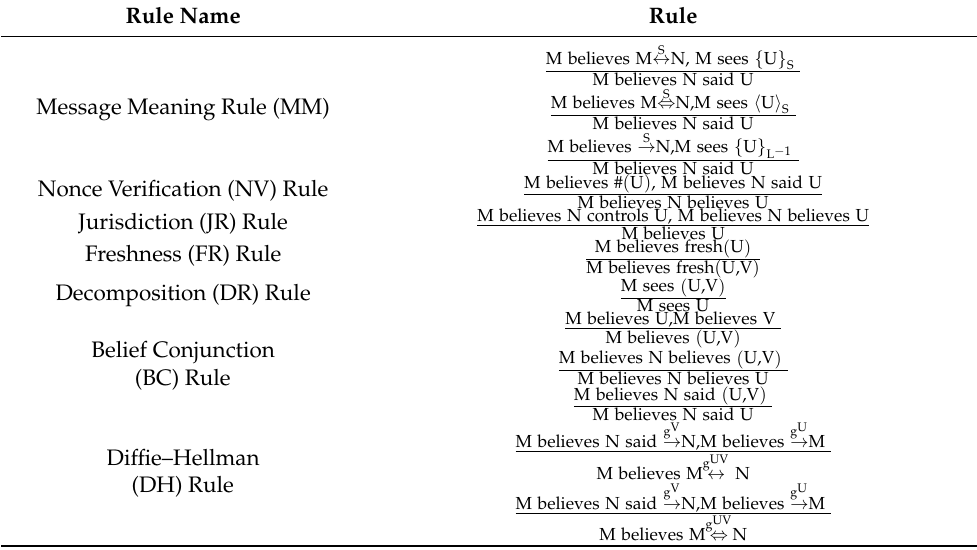
Table 2. BAN logic rules.